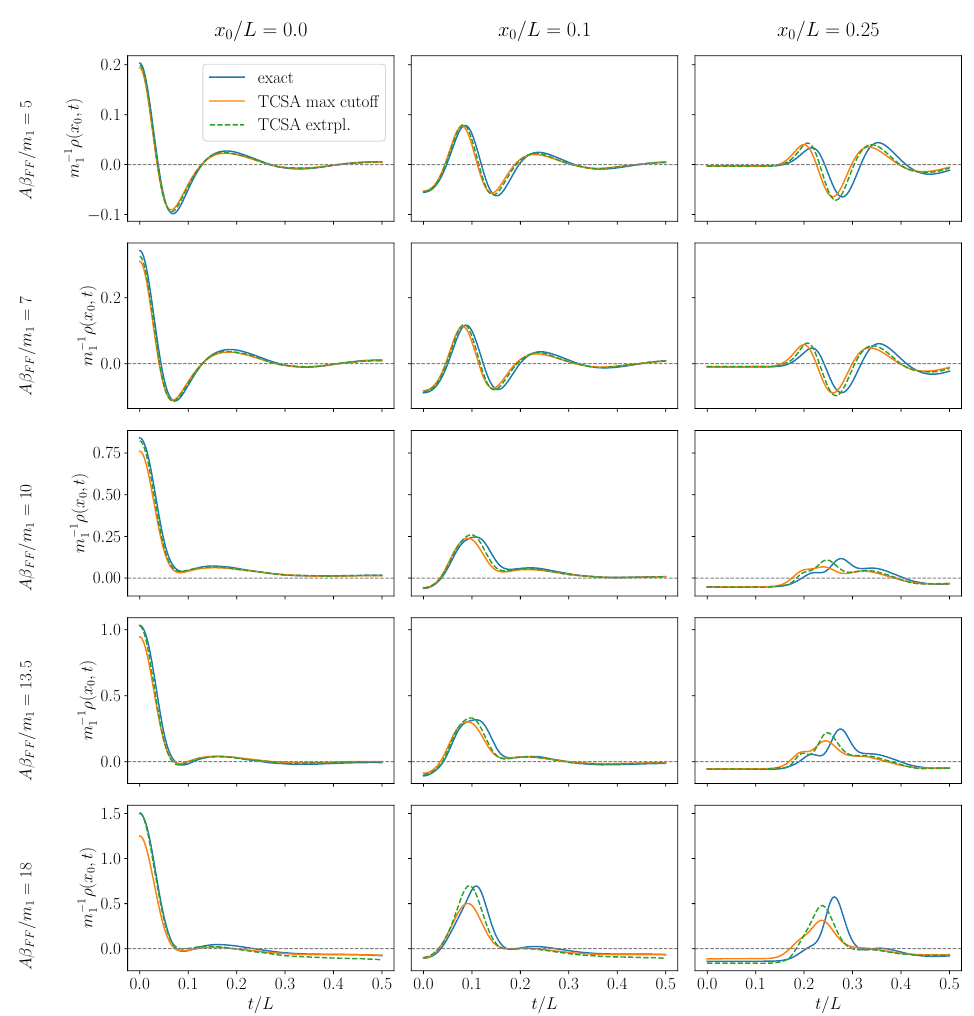
Figure 4.12: Comparison between TCSA and exact results for the dynamics at the free fermion point: The plots show the rescaled soliton density m − 1 function of time t at three different fixed positions x height A of the initial bump. The different curves in each plot correspond to the exact free fermion time evolution (blue line) and the TCSA results at the maximum cut-off used in the simulations (red line) and after extrapolation (dashed green line) (see Appendix A.3 for